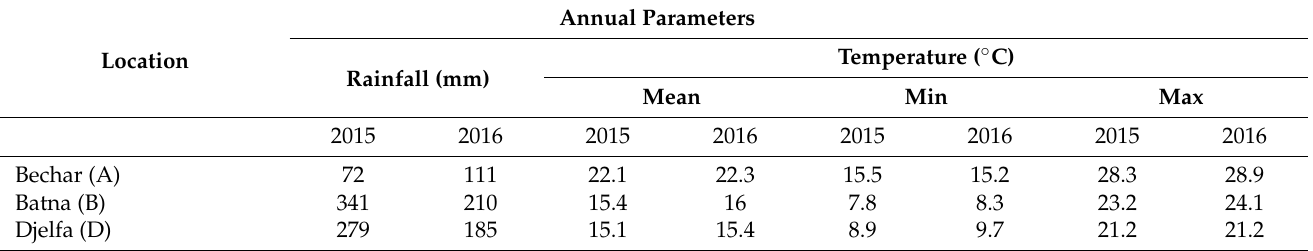
Source: National Meteorology Office of Algeria